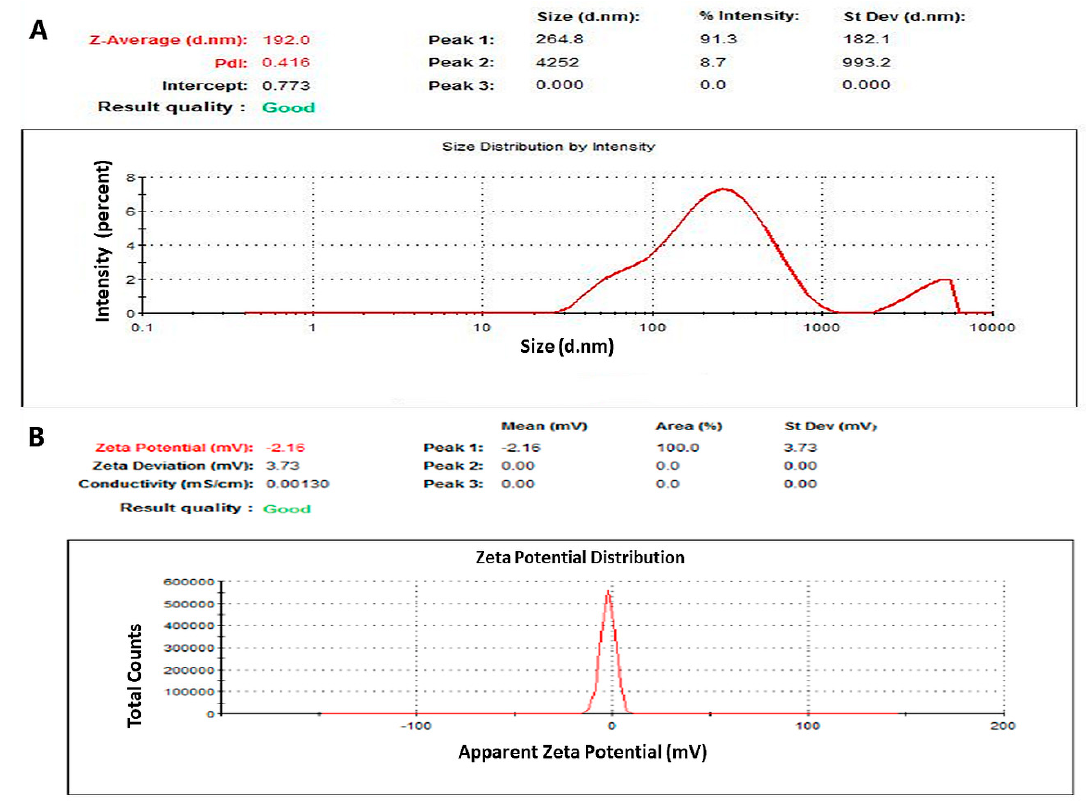
Table 1. Characteristic of Blank and PTX-NaCNs.